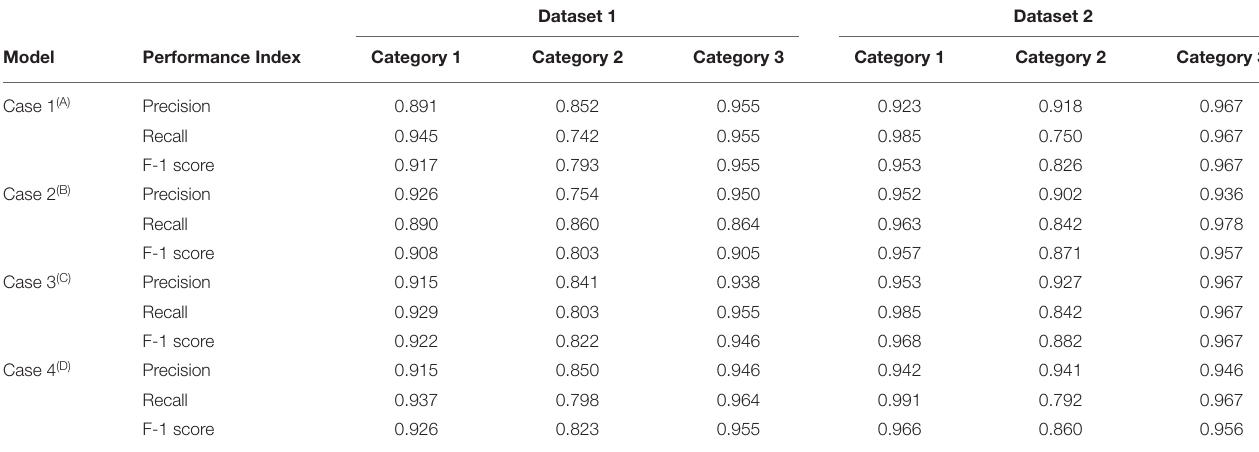
TABLE 4 | Classification performance of the CNN model when classifying the testing set of Dataset 1 (maturing and non-matured spikes) and Dataset 2 (non-matured spikes) in the cases of the study presented different weights in the loss function [weight in Category 1, weight in Category 2, weight in Category 3].